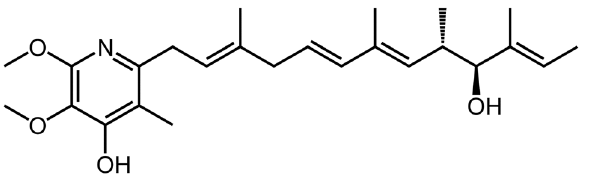
Figure 1. Chemical structure of piericidin